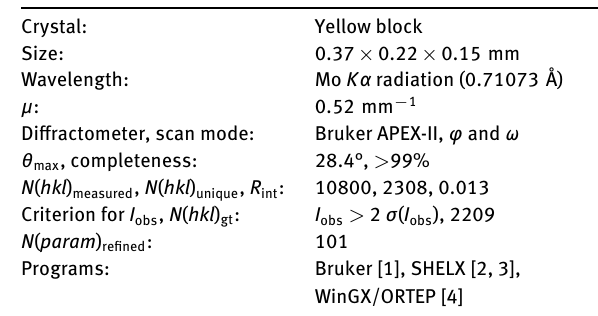
Table 1: Data collection and handling.